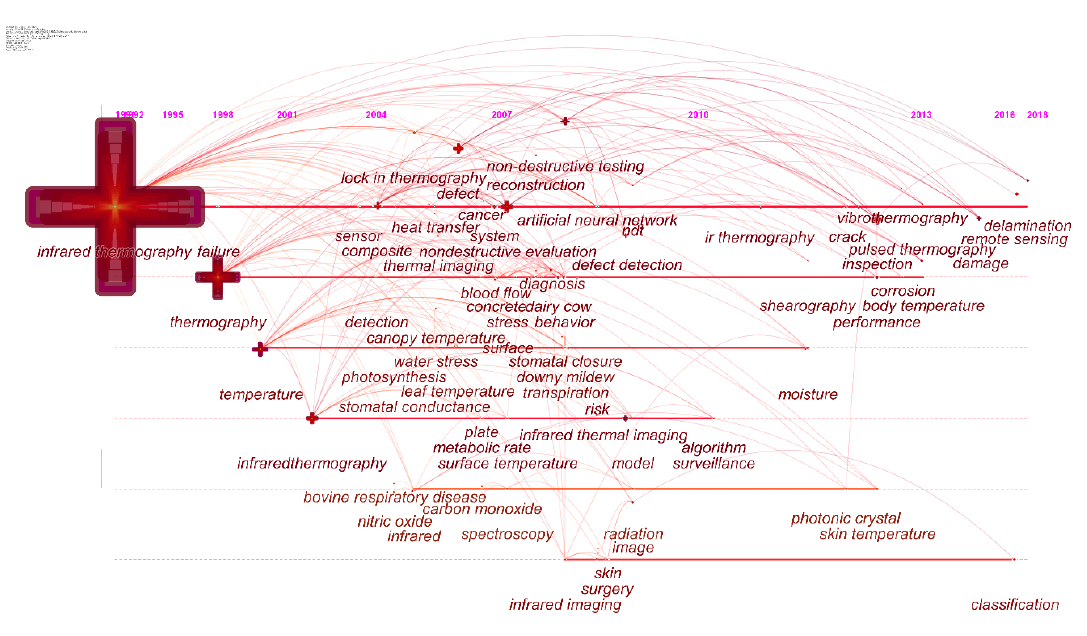
Figure 8. Keyword timeline view of infrared detection technology studies.